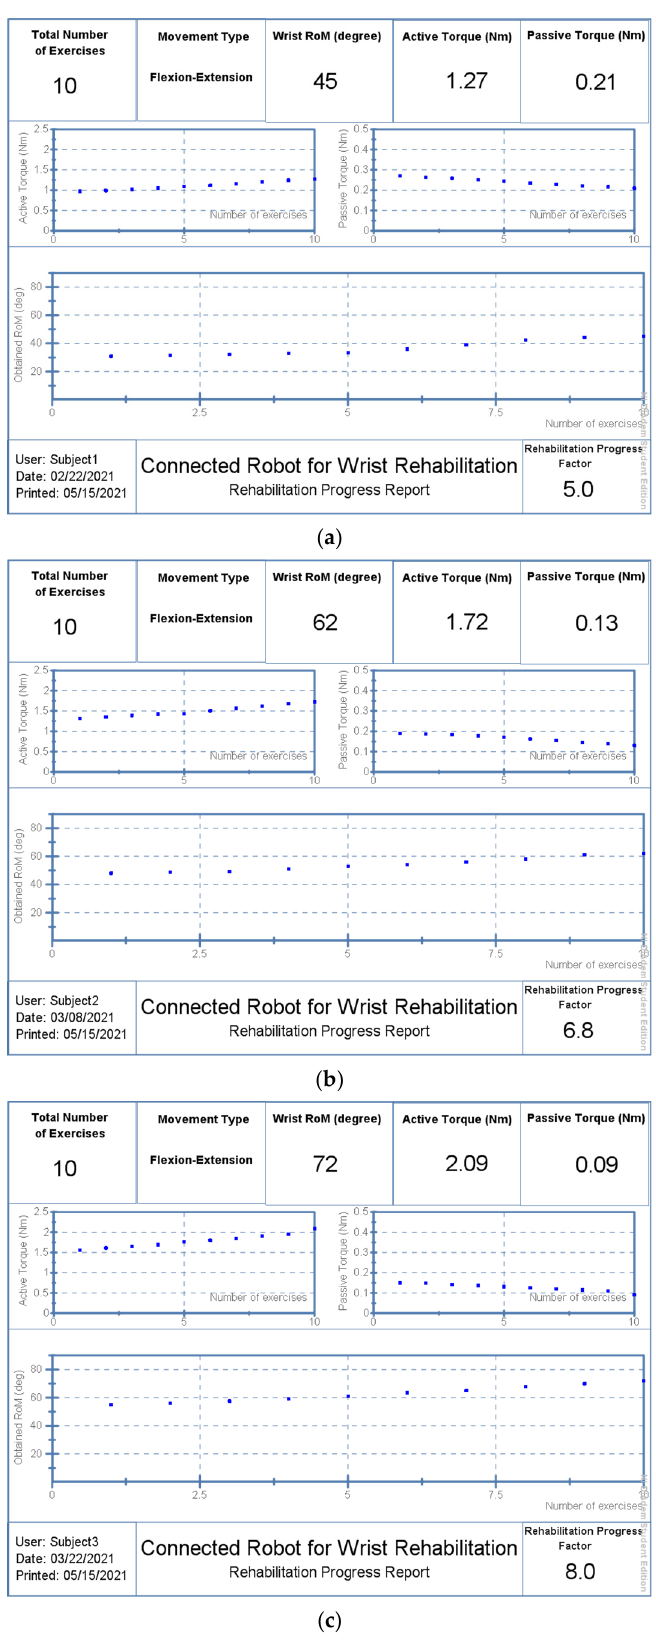
Figure 16. Generated reports: ( a ) Patient 1; ( b ) Patient 2; ( c ) Patient 3.